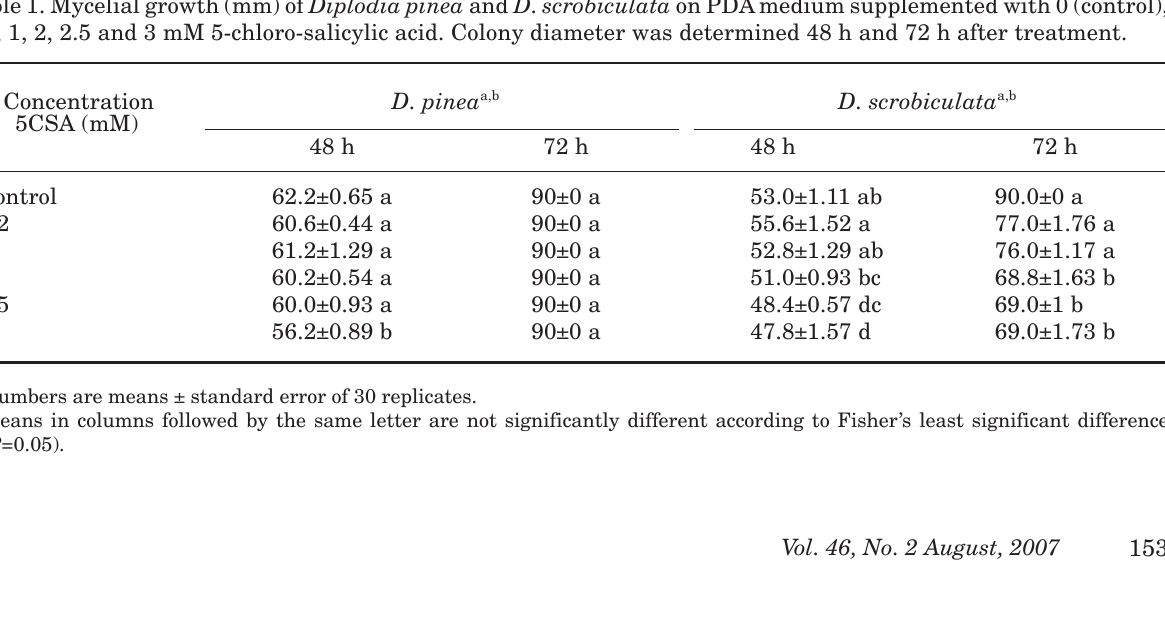
Table 1. Mycelial growth (mm) of Diplodia pinea and D. scrobiculata on PDA medium supplemented with 0